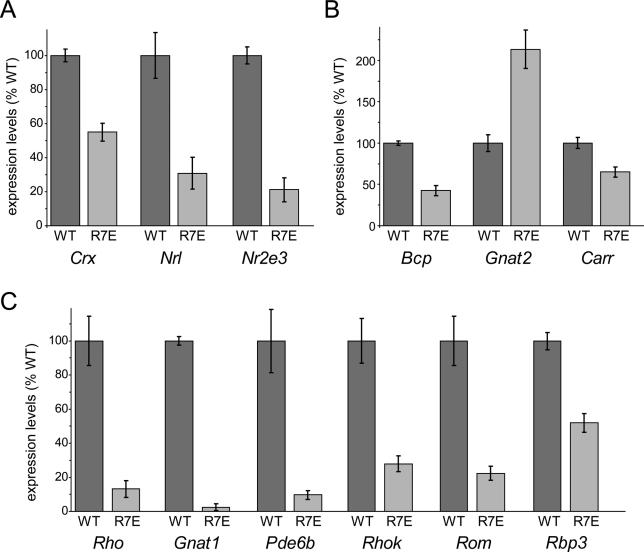
Comprehensive Characterization of Specific Transcriptional Alterations in the Retina from SCA7 MicemRNA levels were quantified by real-time PCR of reverse transcribed RNA from 2-mo-old WT and R7E retina. Expression levels are represented as a percentage of the mean of WT littermate mice after normalization toPpia orArbp levels. In each panel, each bar represents the mean value ± the standard error of the mean (SEM) (n = 3–6).(A) Down-regulation of genes encoding transcription factors,Crx, Nrl, andNr2e3, involved in photoreceptor differentiation and maintenance.(B) Expression analysis of cone-specific genes,Bcp, Gnat2, andCarr, in WT and R7E animals.(C) Severe down-regulation of rod-specific genes,Rho, Gnat1, Pde6b, Rhok, Rom, andRbp3, encoding components of the phototransduction machinery.